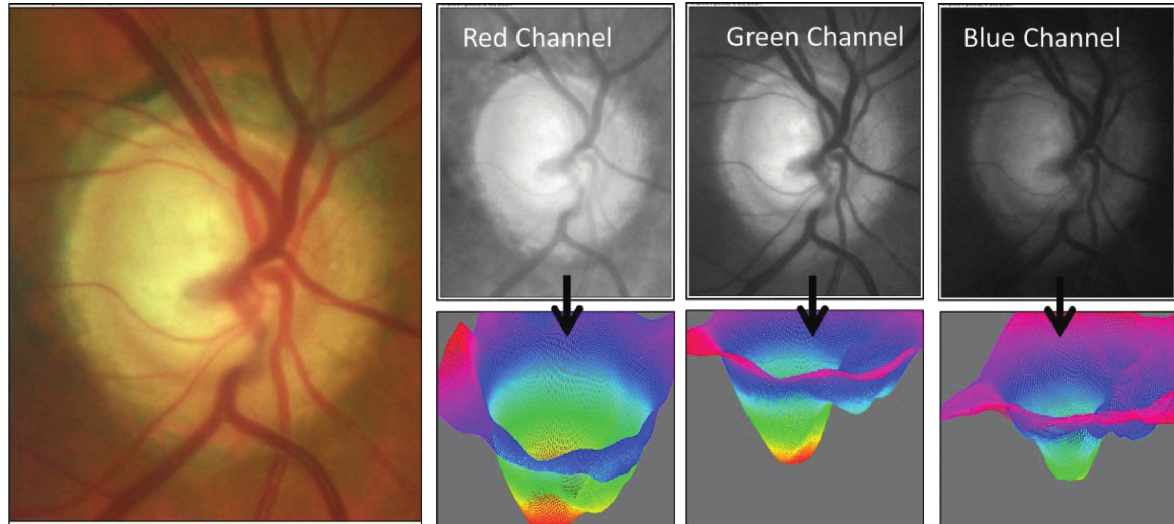
Figure 3: Splitting of the RGB channels in fundus images of the optic nerve and 3D volumetric conversion.